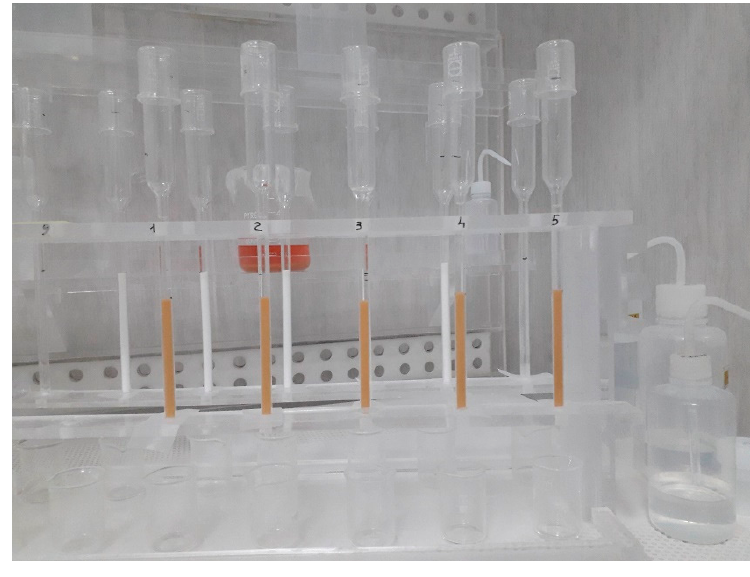
Figure 2. Quartz columns for Li separation by chromatographic techniques.